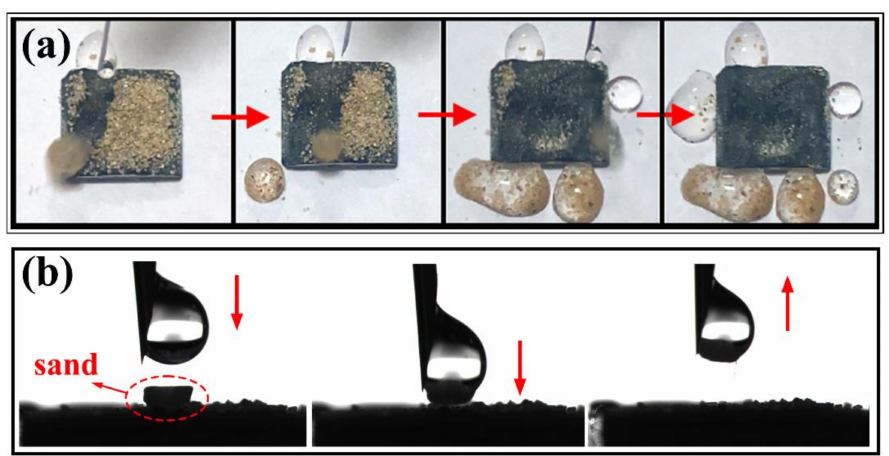
Figure 6. ( a ) Self-cleaning process of the sample on an inclined surface; ( b ) the process of self-cleaning the surface particles on the horizontal